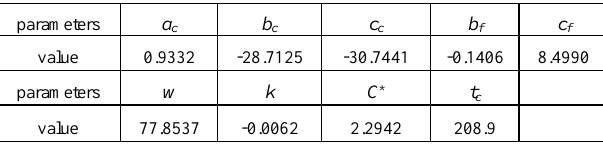
Table 1. The optimized parameters of the UM for Kobresia